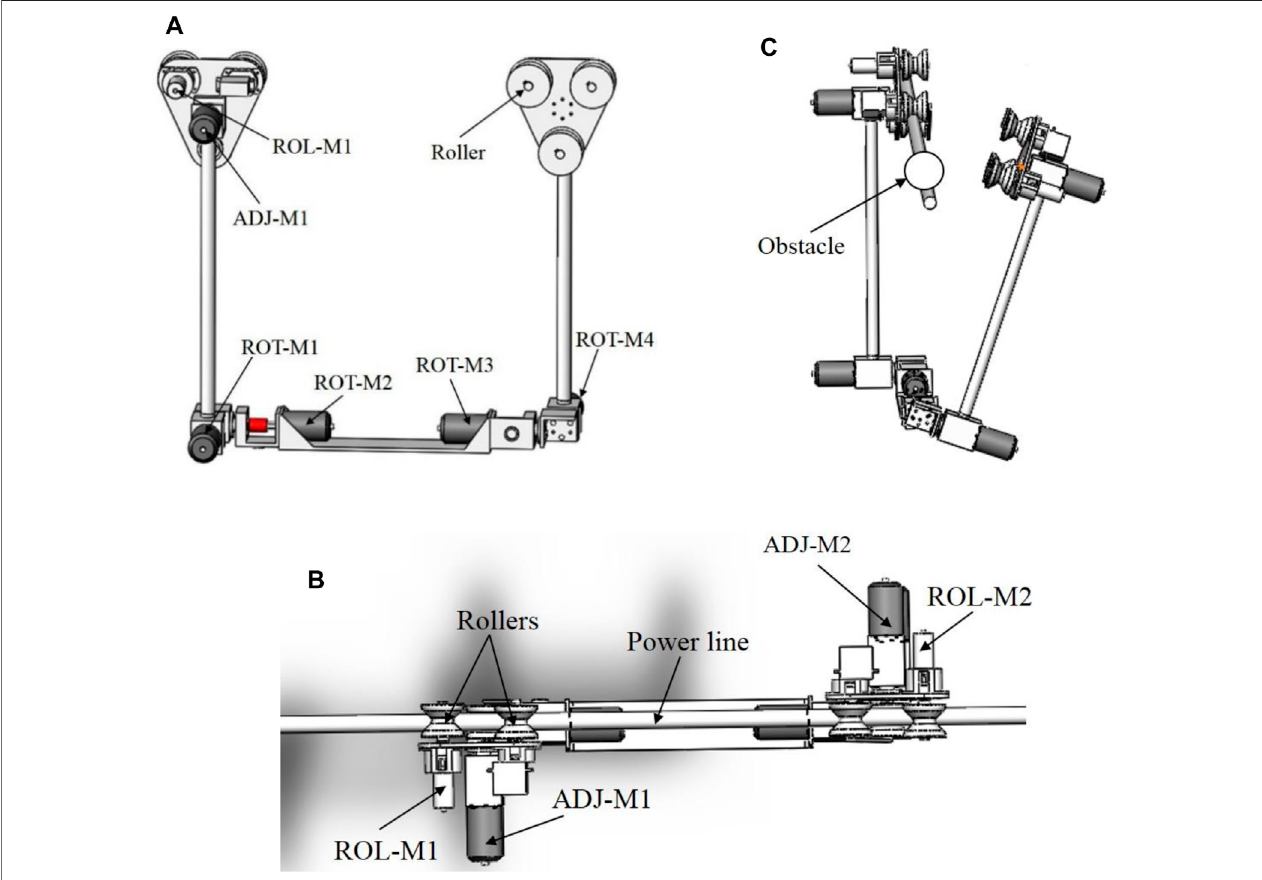
FIGURE 1 | The structure of the dual-arm PTLI robot. (A) Side view; (B) Obstacle avoidance; (C) Plan view. The system has eight motors, two motors (ROL-M1 and2) drives the wheels, two motors (ADJ-M1 and 2) aligns the grippers on the line, and four motors (ROT-M1 – 4) adjusts the arms.